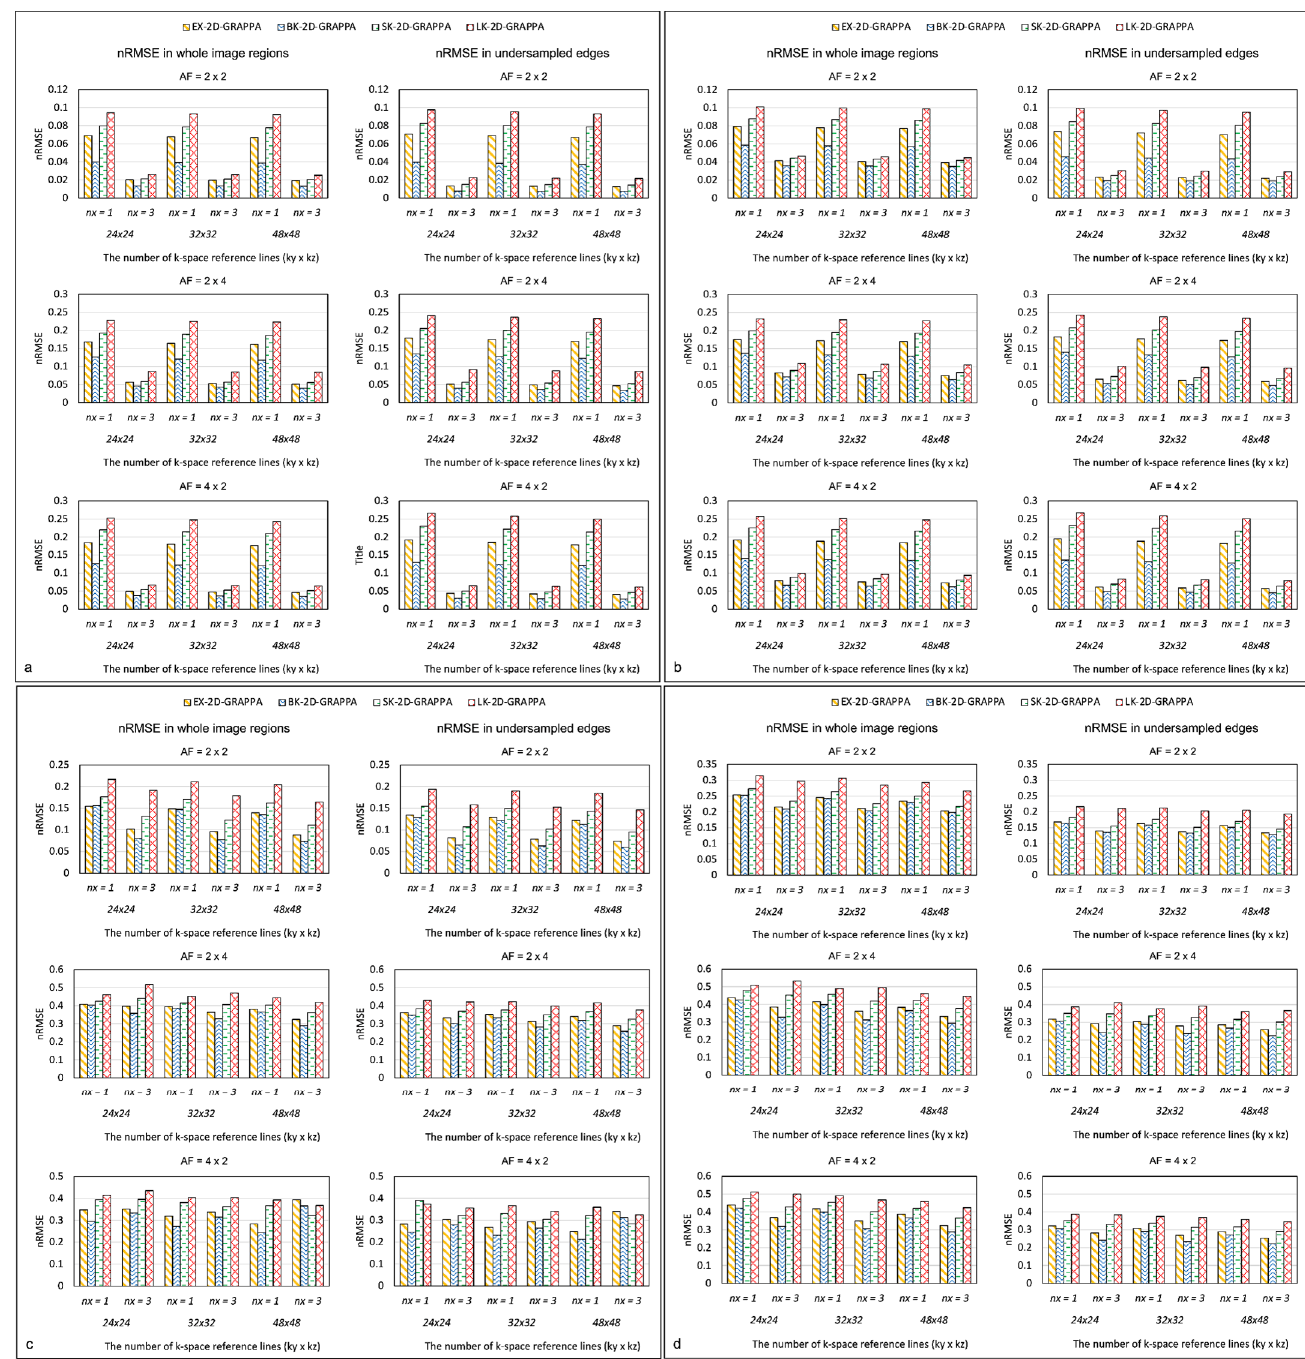
Figure 9. The nRMSE of 2D-GRAPPA algorithms in ( a ) noise-free, ( b ) noise-added, ( c ) phantom and ( d ) in vivo data. BK-2D-GRAPPA algorithm shows the best performance. nx represents the kernel size along the x direction. nx = 1: basis kernel, nx = 3: expanded kernel.